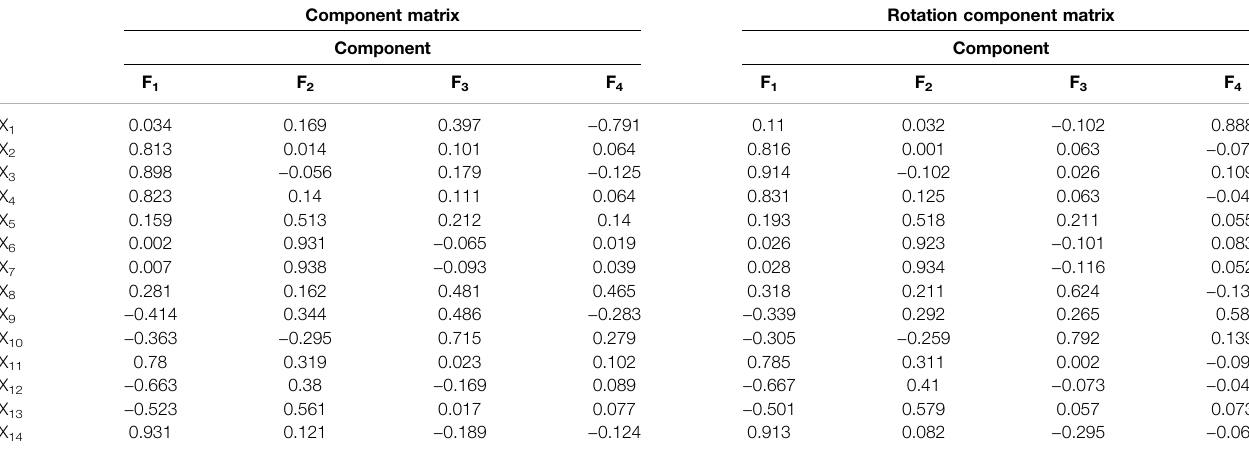
TABLE 4 | Component matrix and rotation component